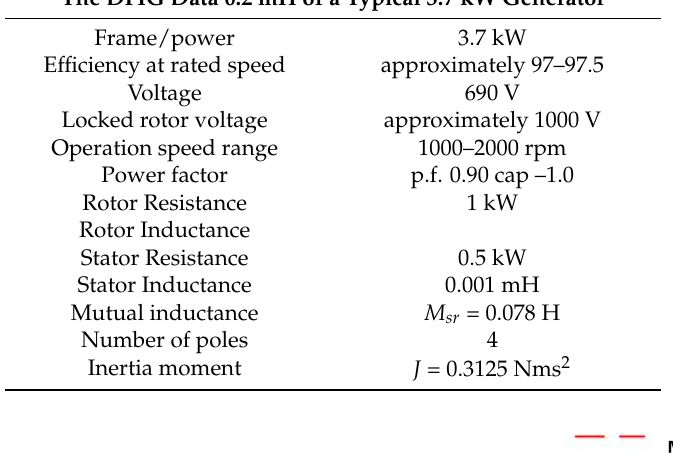
Table 1. The DFIG data sheet.